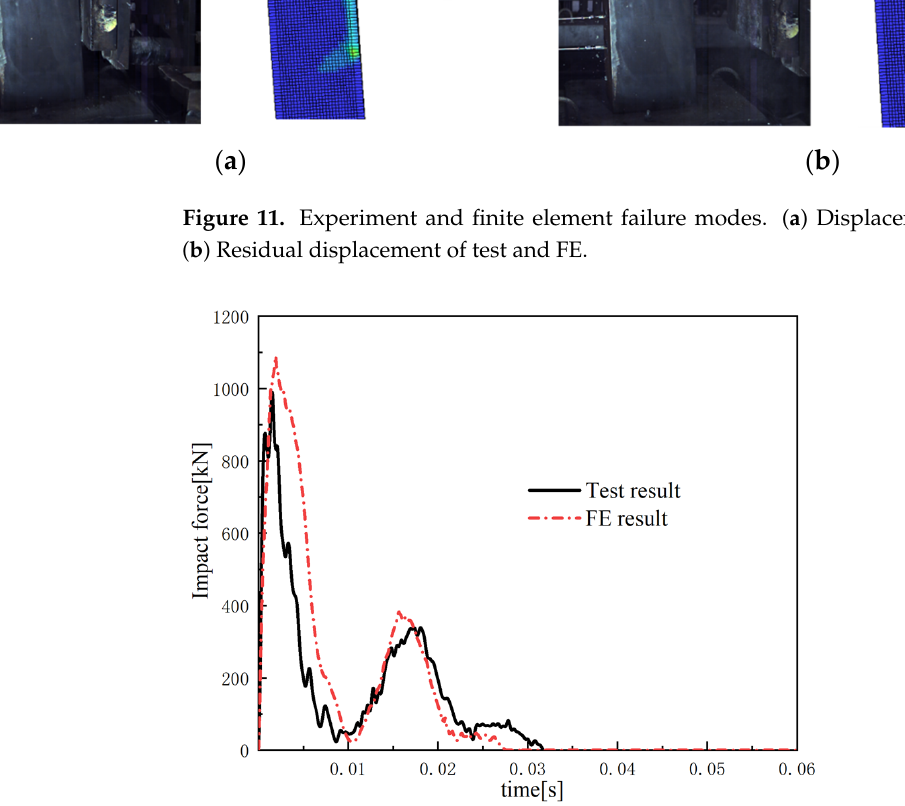
Figure 12. Comparison -impact-time history curves from test and finite element simulation.